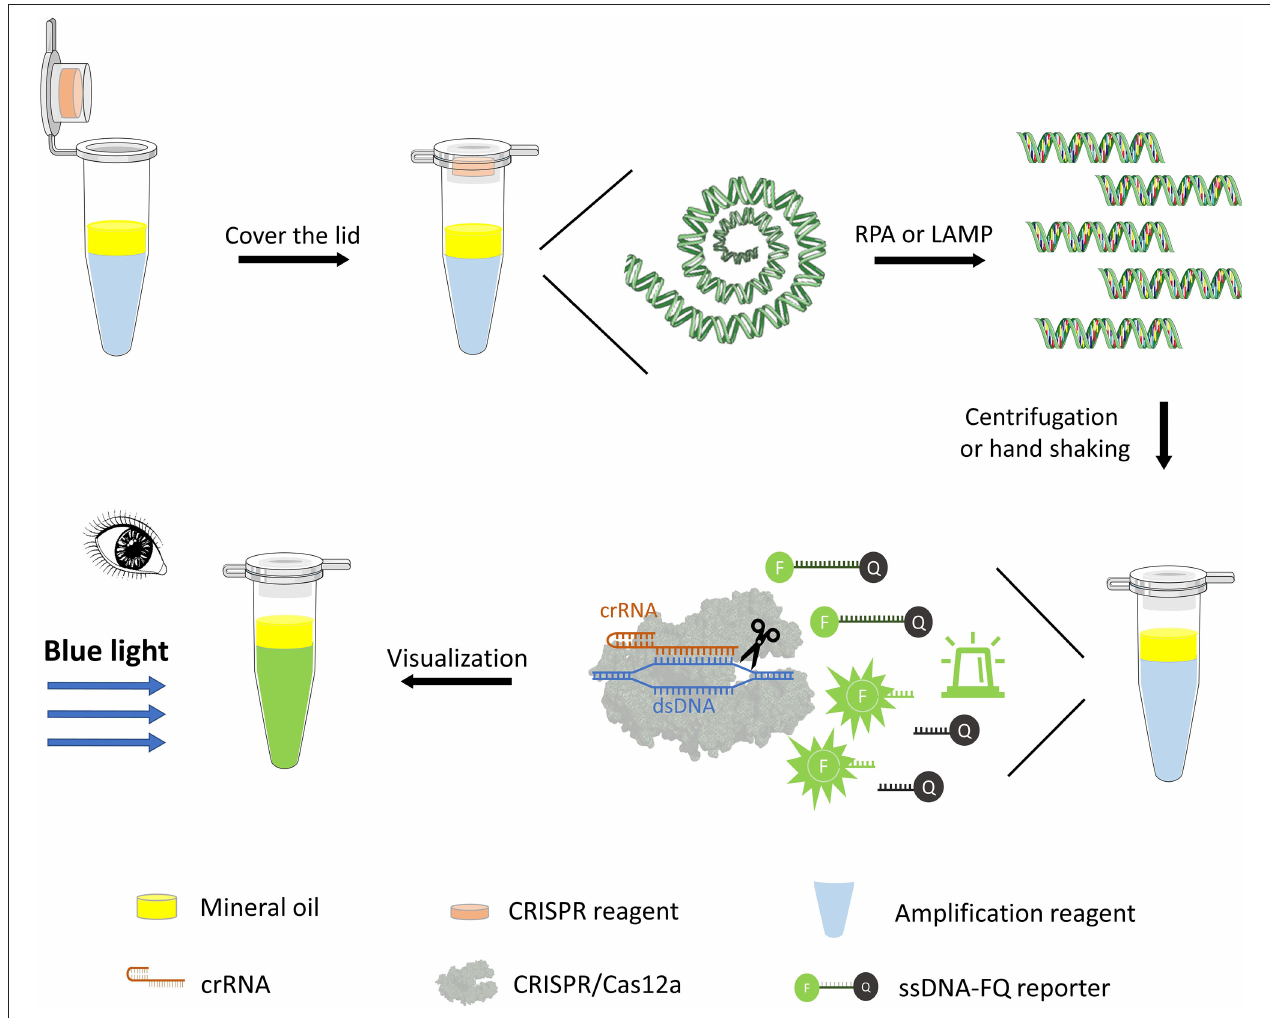
FIGURE 1 | One-pot visual detection system. One-pot visual detection system showing the process of DNA pre-amplification, Cas12a/crRNA cleavage reaction, and fluorescence visualization. RPA or LAMP reagent, crRNA, Cas12a enzyme, and ssDNA-FQ reporter are all in one tube, with mineral oil sealing. Target binding of Cas12a will unleash its ability to digest ssDNA-FQ reporter. The fluorophore FAM (F) is quenched by a quencher (Q) if intact and emits fluorescence when cleaved, which is visual under the blue light.